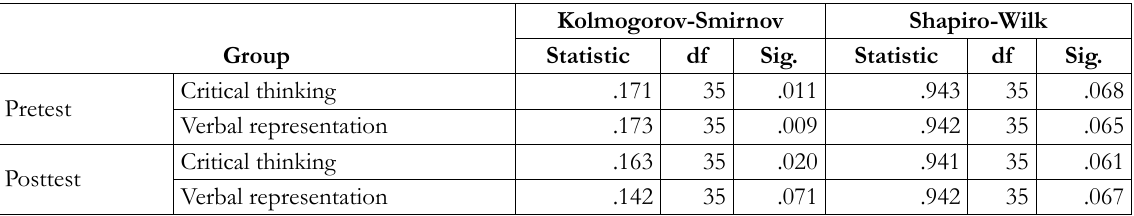
Table 4. Result of normality test of the experimental class